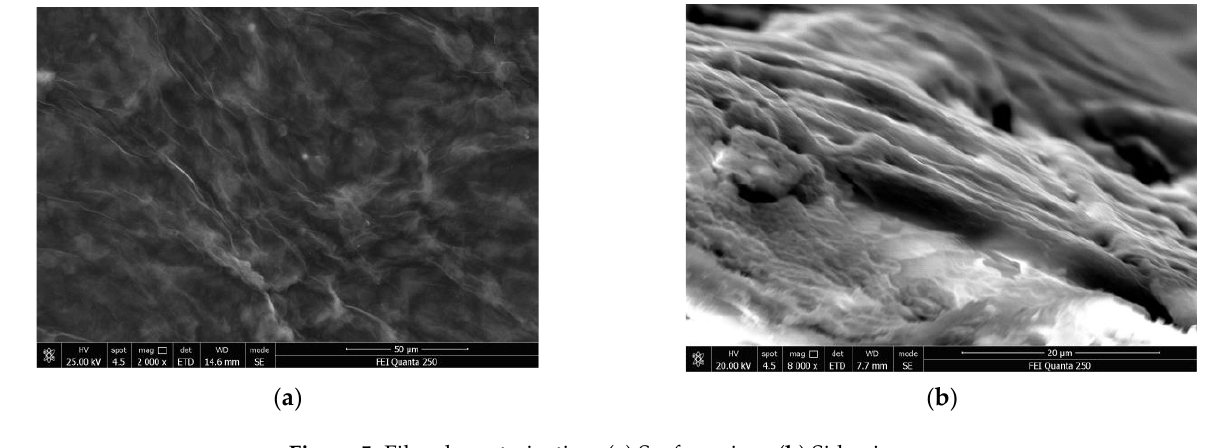
Figure 6. Performance testing system of SAW devices.